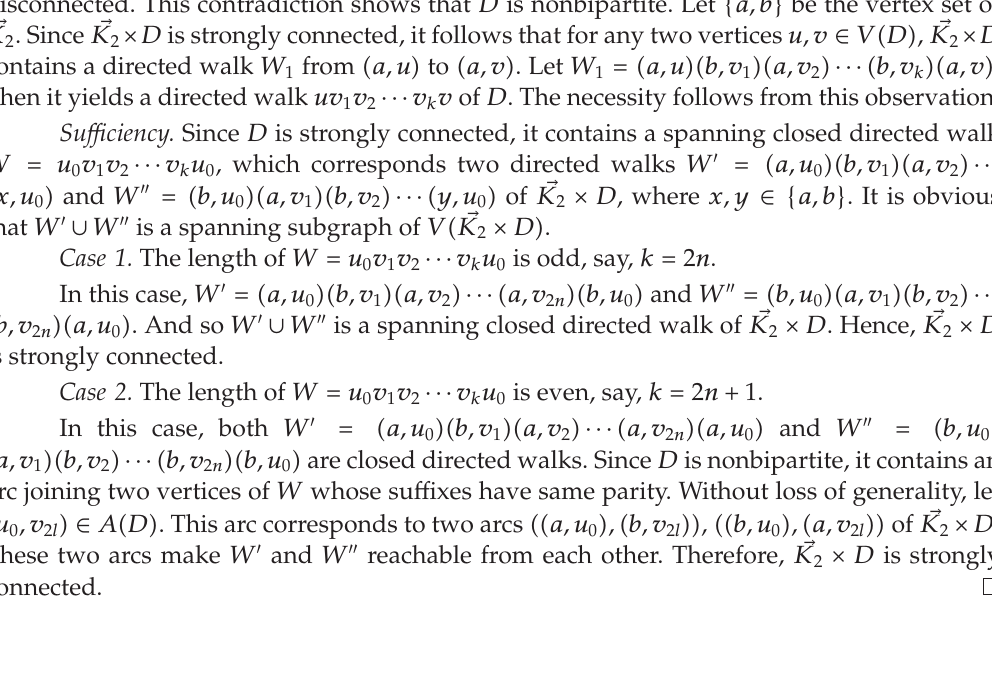
Figure 1: Orientations of direct-product digraph